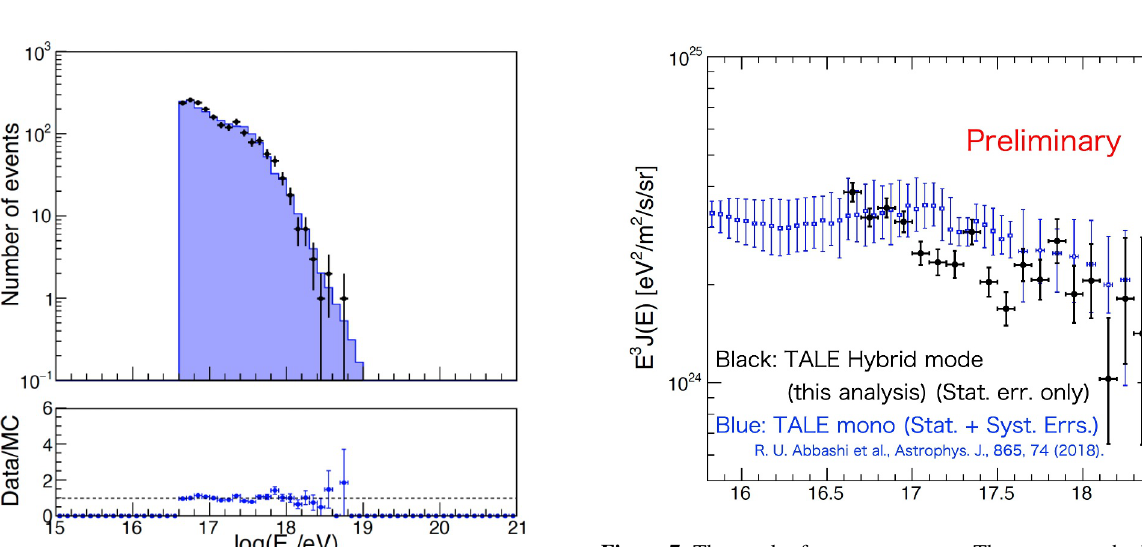
Figure 7. The result of energy spectrum. The spectrum obtained in this analysis is shown by black marker points, while that re- ported by TALE FD mono observation is shown by blue